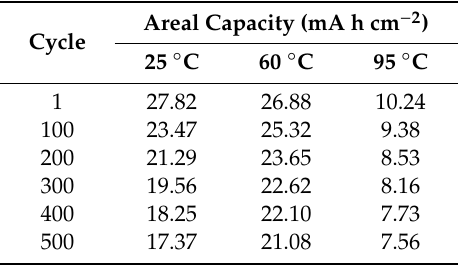
Table 4. The areal capacity for three-electrode configuration mA h cm − 2